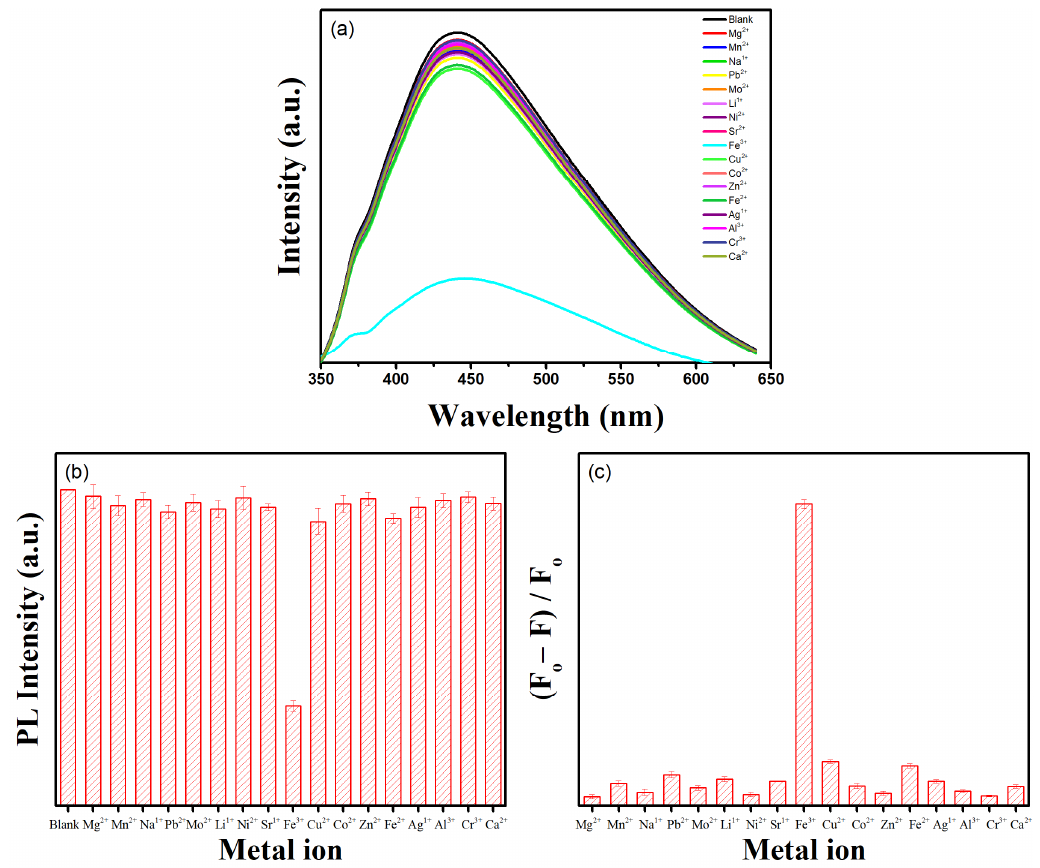
Figure 8. ( a ) Fluorescence spectra of GQDs-250-12 solution in the presence of different metal ions at 340 nm excitation. ( b ) Comparison of the emission intensity of GQDs in the absence and presence of various metal ions. ( c ) Comparison of the affinity of a range of metal ions towards GQDs. It is critical to comprehend the quenching mechanism in order to have further under- standing of the strong quenching behavior of Fe 3+ . The surface functional groups for which Fe 3+ has a strong affinity are hydroxyl/carboxyl groups present on the surface of GQDs. A stable molecule is created as a result of the attraction of hydroxyl/carboxyl groups on Fe 3+ [32]. Fluorescence quenching occurs when an excited electron partially travels towards the d orbital of Fe 3+ instead of relaxing radiatively [28,32]. Under identical experimental settings, the scientific affinity of several metal ions for GQDs was investigated. The find- ings (Figure 8c) show that among the seventeen different metal ions, Fe 3+ has the highest affinity for GQDs. These findings suggest that these GQDs have a promising future in the field of selective Fe 3+ practical detection. In real-world sensing applications, sensitivity is a crucial component in addition to selectivity. The impact of various Fe 3+ concentrations on the PL intensity of GQDs was carefully investigated in order to explore the sensitivity of the GQD-based sensor. Figure 9a shows how the PL intensity of the GQDs solution changed as varied amounts of Fe 3+ (0.1 to 100 µM) were added. With a gradual increase in the quantity of Fe 3+ , a consistent drop in PL intensity is clearly seen. With a rise in Fe 3+ concentration, PL quenching